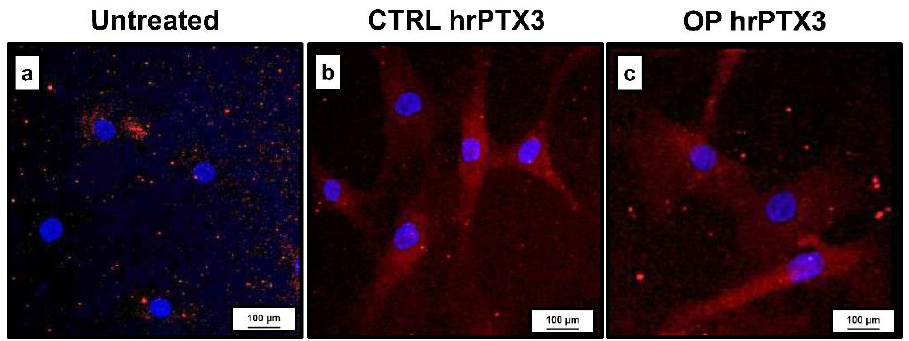
Figure 4. Immunostaining for PTX3 on CTRL and OP primary osteoblasts culture. ( a ) In untreated cultures, a slight expression of PTX3 can be observed in a few cells. In both CTRL ( b ) and OP ( c ) treated cultures, the uptake of hrPTX3 is observed at the cytoplasmic level. Small autofluorescent calcification- like structures are also observed. 40x images, scale bar represents 100 μm.